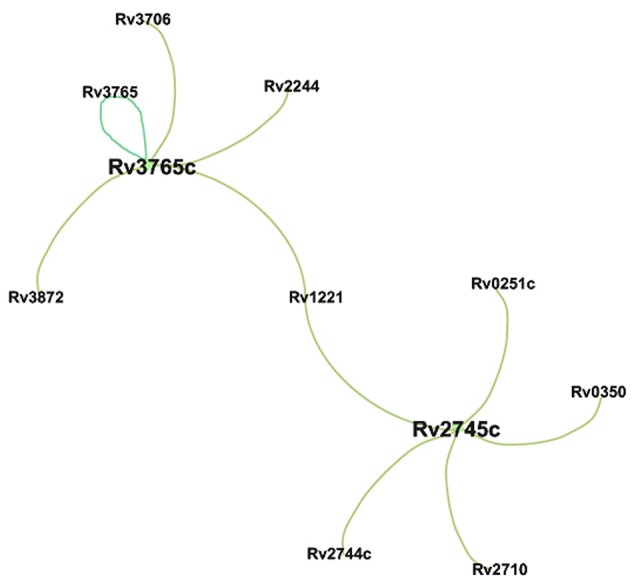
Over-expressed TF identified in FNRP1 vs. FE. Genes over-expressed in the FNRP1 vs. FE that interact with Rv3765c, according to the Minch's data (2015). Because, Minch and co-workers did not identified genes controlled by the TF Rv2745, the figure showed those described in the literature (Estorninho et al., 2010; McGillivray et al., 2014).